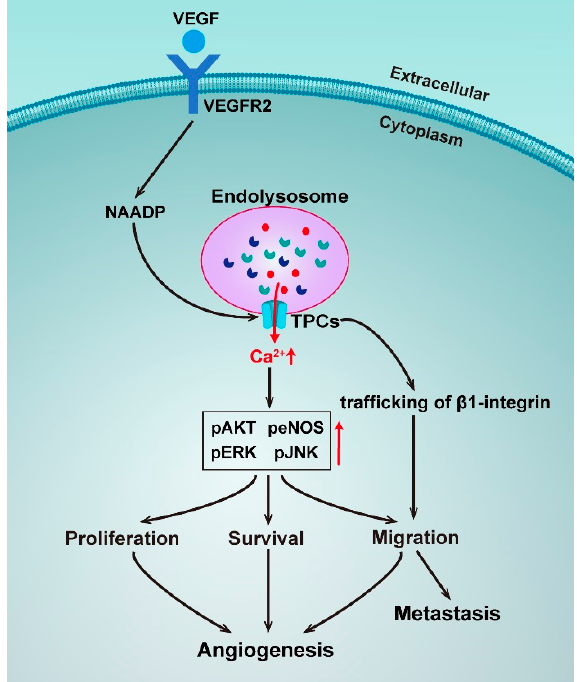
Figure 3. Schematic representation of the roles of TPCs in angiogenesis and metastasis.